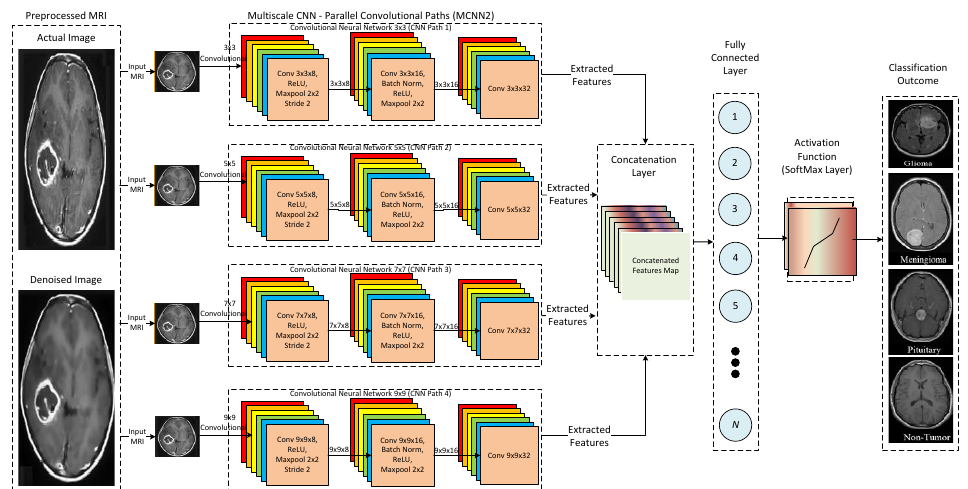
Figure 11. Detailed architecture of the proposed MCNN3.